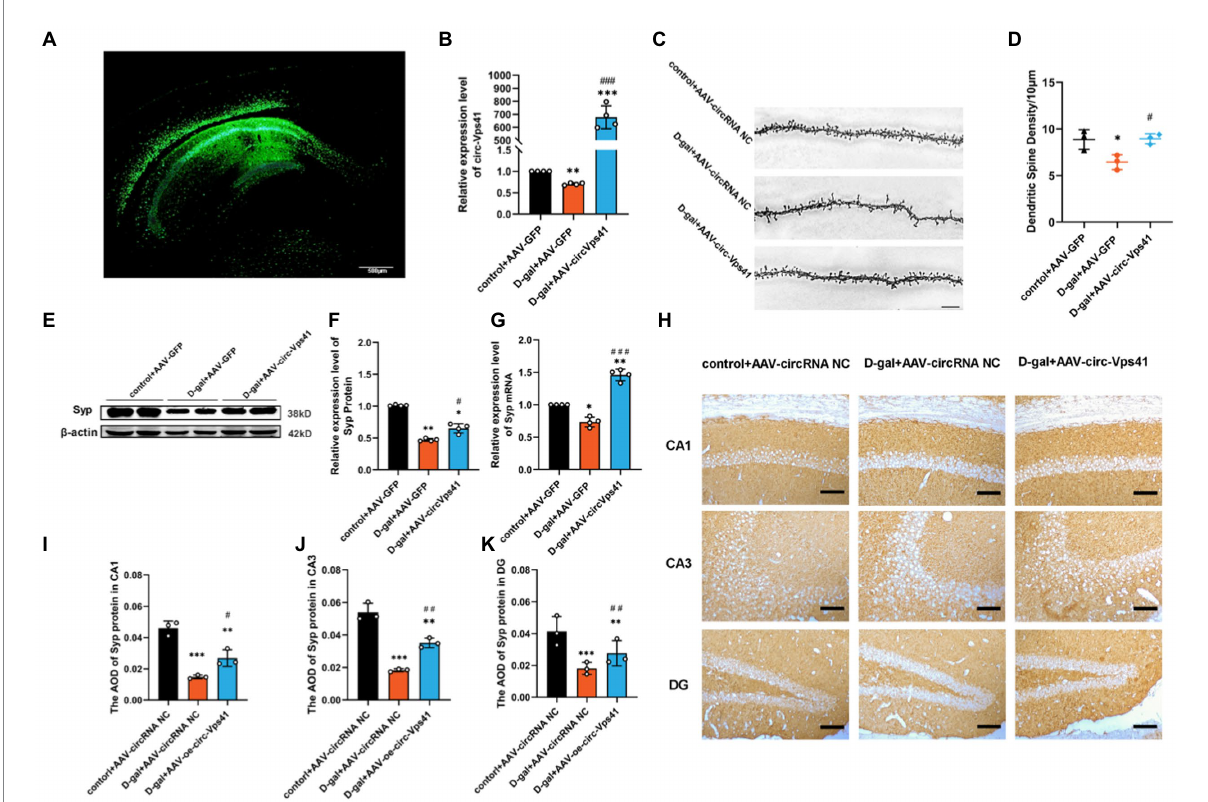
FIGURE 2 Overexpression of circ-Vps41 improves dendritic spine density and Syp expression in D-galactose-induced aging mice (A) Representative image of stereotactic injections in the hippocampal CA1 area. (Scale bars = 500 μ m). (B) The expression level of circ-Vps41 was tested by qRT–PCR in the hippocampus of mice ( n = 4 for the control+AAV-GFP group, n = 4 for the D-gal+AAV-GFP group, n = 4 for the D-gal+AAV-circ-Vps41 group). The control+AAV-GFP group was normalized to 1. (C,D) Representative images and quantification of Golgi-Cox staining in the hippocampus of the three groups of mice. ( n = 3 for the control+AAV-GFP group, n = 3 for the D-gal + AAV-GFP group, n = 3 for the D-gal+AAV-circ-Vps41 group, scale bars = 10 μ m). (E,F) Representative images and quantification of Syp in the hippocampus of the three groups of mice were tested by western blot. (G) The expression level of Syp mRNA was tested by qRT–PCR in the hippocampus of mice in the three groups. The control + AAV-GFP group was normalized to 1. (H–K) Representative images and quantification of Syp in the hippocampus of the three groups of mice were tested by immunohistochemical staining ( n = 3 for the control + AAV-GFP group, n = 3 for the D-gal + AAV-GFP group, n = 3 for the D-gal + AAV-circ-Vps41 group, scale bars = 100 μ m). * p < 0.05, ** p < 0.01, *** p < 0.001 vs. control + AAV-circRNA NC group; # p < 0.05, ## p < 0.01, ### p < 0.001 vs. D-gal+AAV-GFP group; Data shown as the mean ± SEM. p values, one-way